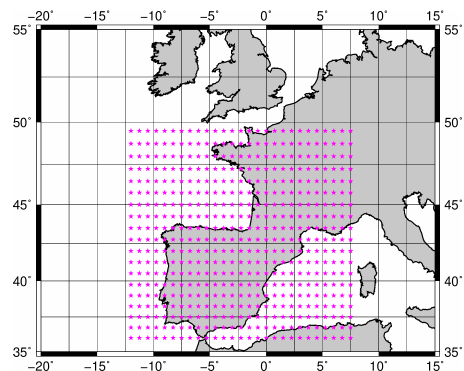
Figure 3. ERA-Interim domain used for downloading analysis data.